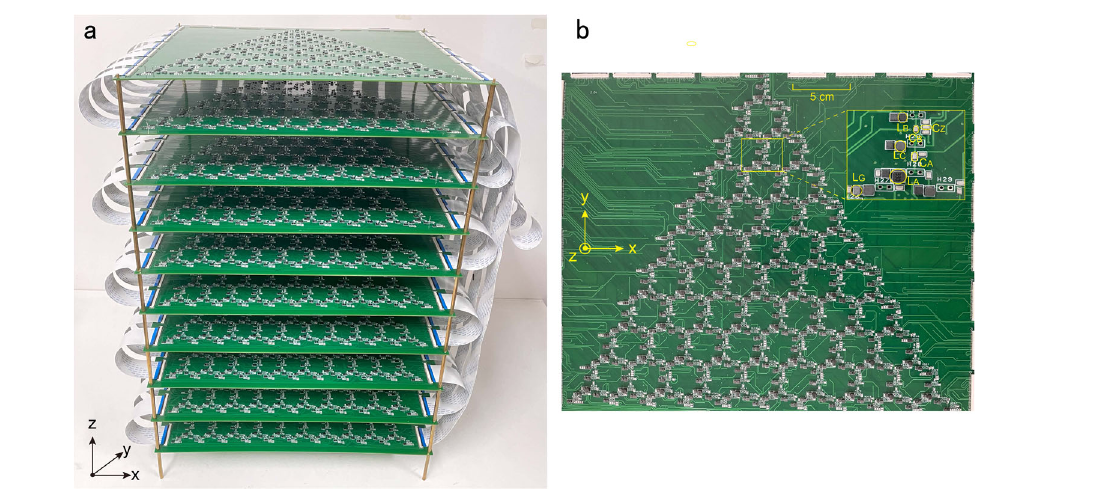
Fig. 4 | Hinge states and Fermi arcs. a The projected admittances along k z axis. b Hinge-state dispersion connecting the projection of the Weyl points on k z axis. The red dots and the color map in a and b represent the theory and experimental hinge spectrum, respectively. c The numerical “ Fermi arc ” of the surface states at